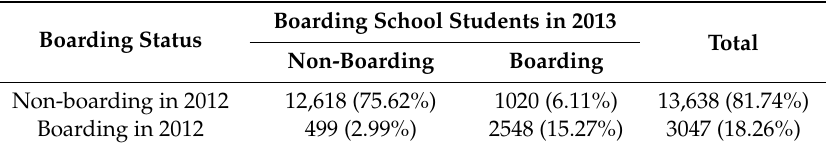
Table 2. Boarding status percentages.